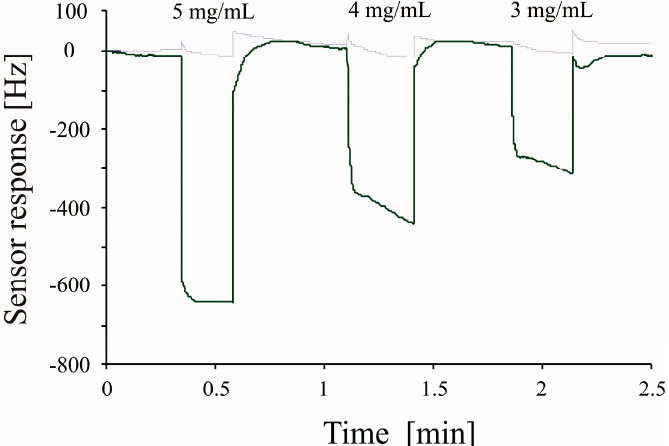
Figure 7. Concentration dependent frequency response of polyurethane layer imprinted with E. coli strain W replica (1 mg of bacteria approximately corresponds to 5 × 10 8